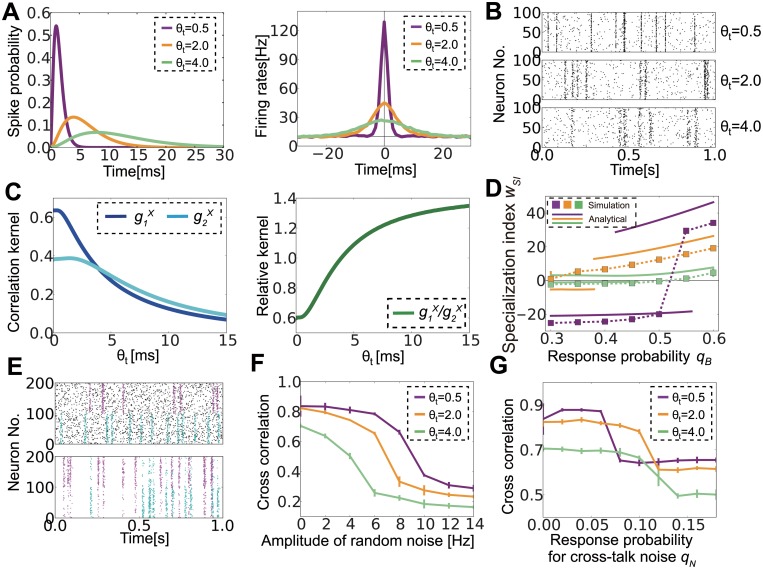
Optimal correlation timescale changes depending on noise characteristics.(A) Response kernels of input neurons to external events (left) and cross-correlation among input neurons responding to the same source calculated from simulated data (right) for three different correlation timescale parameters θt. (B) Raster plots of input neurons for various θt. Only 100 correlated neurons are plotted although there are 400 input neurons in total. (C) Analytically calculated correlation kernels g
1
X, g
2
X (left), and their ratio g
1
X/g
2
X. (D) Specialization index w
SI for various response probabilities q
B while fixing q
A = 0.6. Lines represent w
R at analytically estimated stable points, and dotted squares represent simulation results. (E) Raster plots of two types of noise. The upper panel shows random noise, whereas the lower panel depicts crosstalk noise. In both panels, the first 100 neurons respond primarily to the cyan source, and the next 100 neurons respond to the purple source. For random noise, the noise (black dots) is independent from the signals, whereas the crosstalk noise (purple dots in the lower half, cyan dots in the upper half) is correlated with the signal for the other population. (F, G) The effects of random noise (F) and crosstalk noise (G) at various correlation timescales.